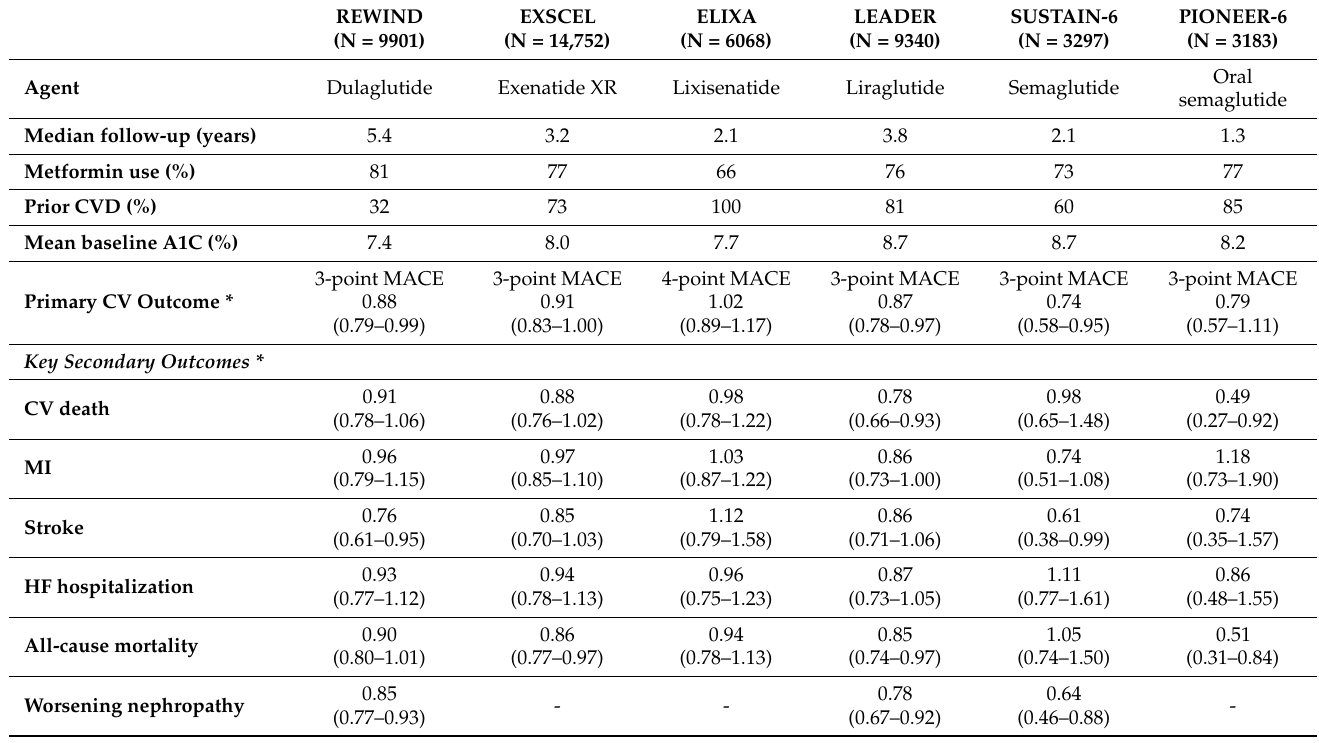
Table 1. GLP-1 Receptor Agonist Cardiovascular outcome trials (CVOTs)